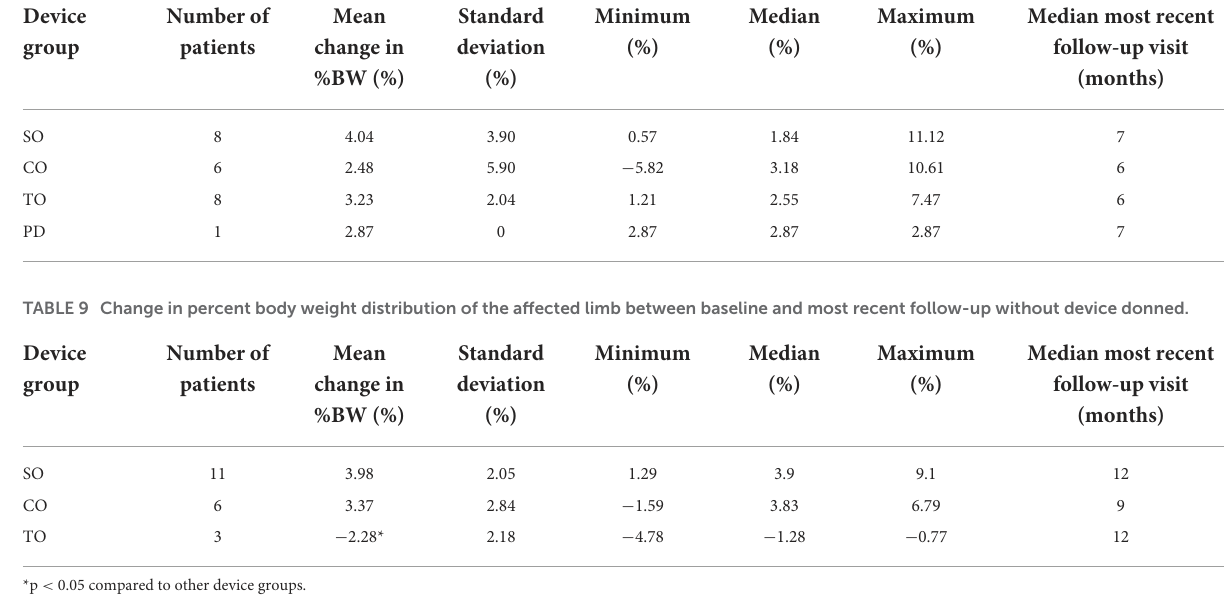
TABLE 8 Change in percent body weight distribution of the affected limb between baseline and most recent follow-up with device donned. Device group